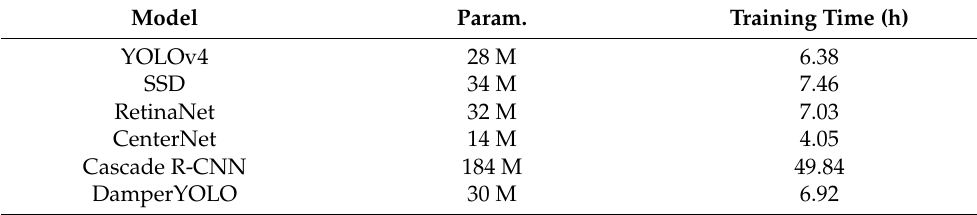
Table 9. Network parameters (Param.) and training time of the different models. Model